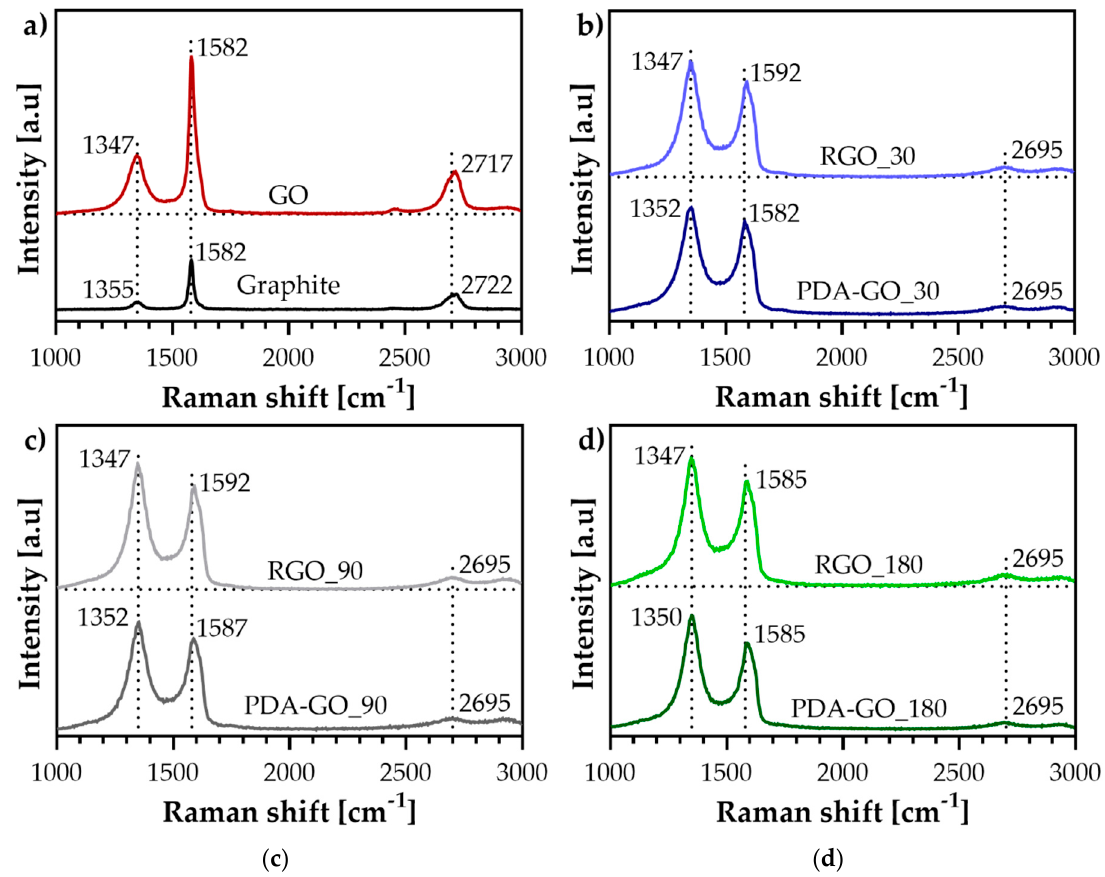
Figure 3. Raman spectra and position of the D , G , and 2D bands of: ( a ) graphite and GO; ( b ) PDA-GO_30 and RGO_30; ( c ) PDA-GO_90 and RGO_90; and ( d ) PDA-GO_180 and RGO_180. Table 2. I D / I G or I D + PDA / I G + PDA of the graphene